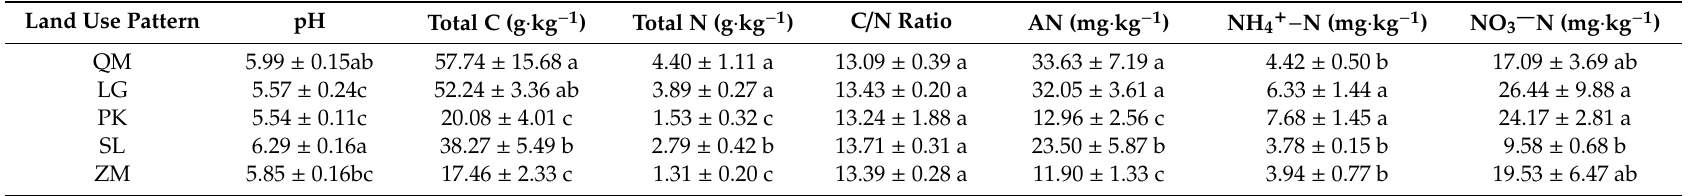
Table 2. Chemical soil characteristics under di ff erent land use